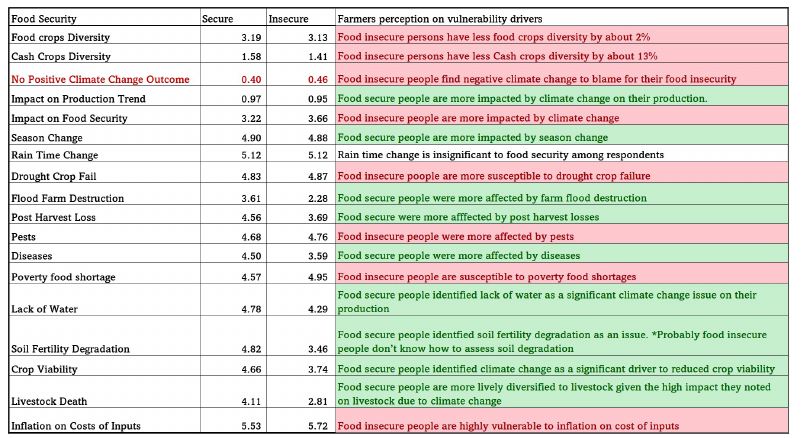
Figure 15. Perceptions of drivers of food insecurity between food-secure and food-insecure households.